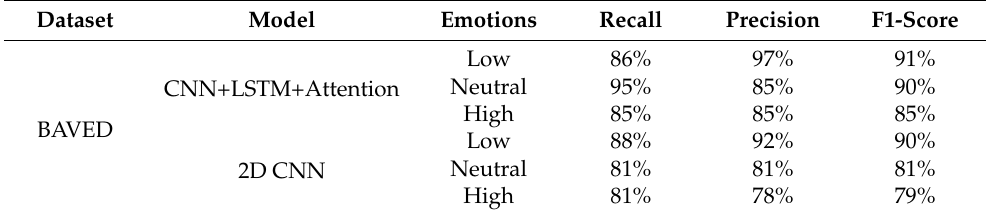
Table 3. Individual class performance evaluation metrics—BAVED.